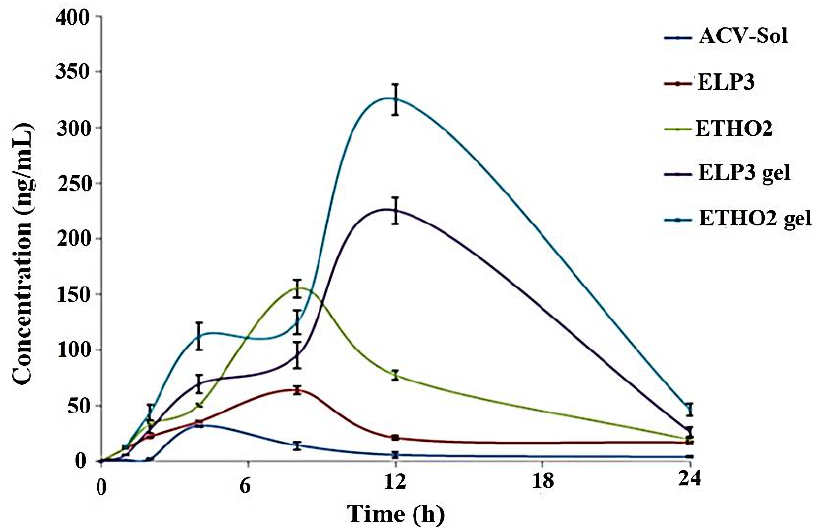
Figure 5. In vivo pharmacokinetic study of various formulations (ACV sol, ELP3, ETHO2, ELP3 gel, and ETHO2 gel) in rat plasma following transdermal application. Table 9. Summary of pharmacokinetic data for various